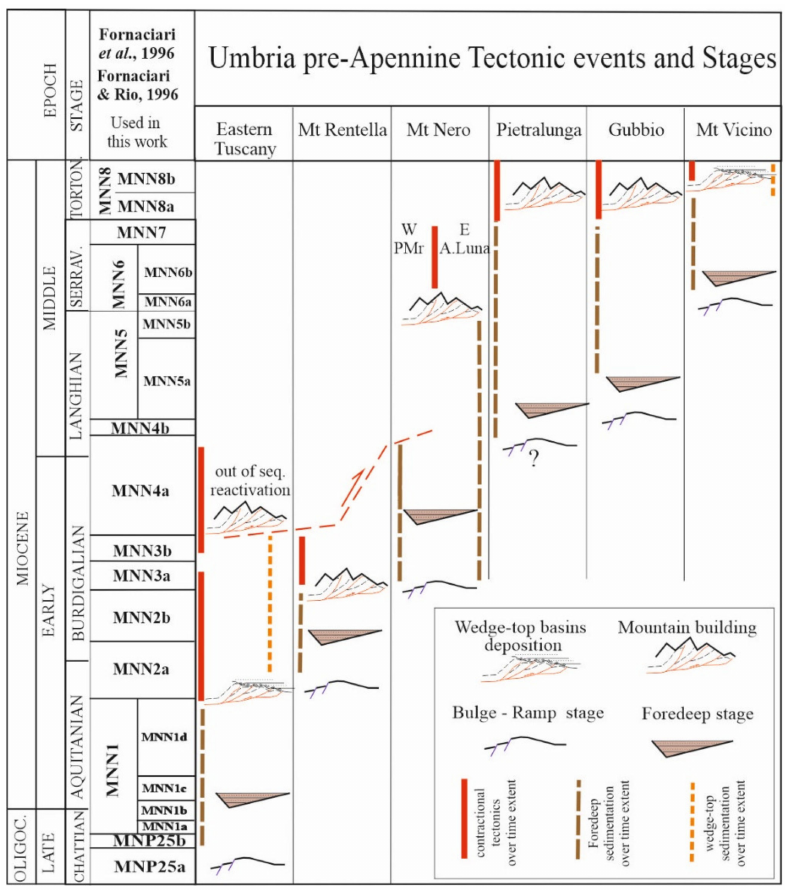
Figure 6. High-resolution timing of sedimentary and tectonic events (referred to the bio- chronostratigraphic scheme of Figure 2) recognized in each of the Units of the Umbria-pre-Apennines (detailed explanations in the text). The scheme is inspired by that proposed for the central Apennines by